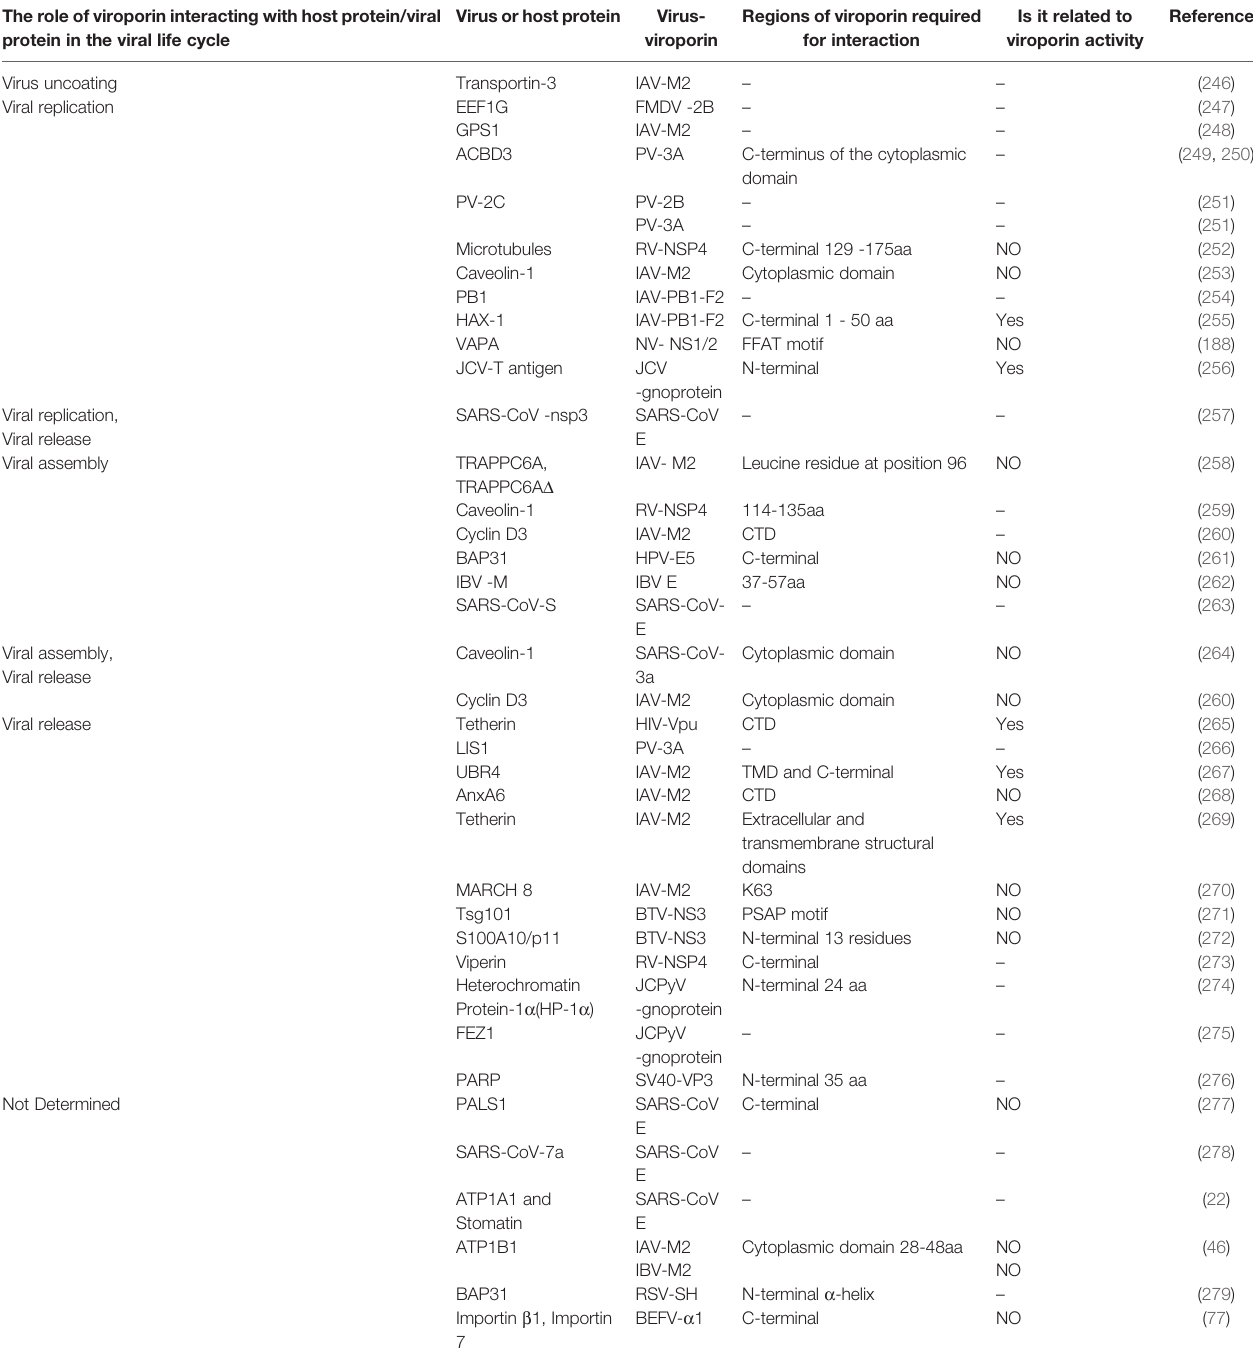
TABLE 3 | The role of viroporins interacting with other host or viral proteins in the viral life cycle. The role of viroporin interacting with host protein/viral protein in the viral life